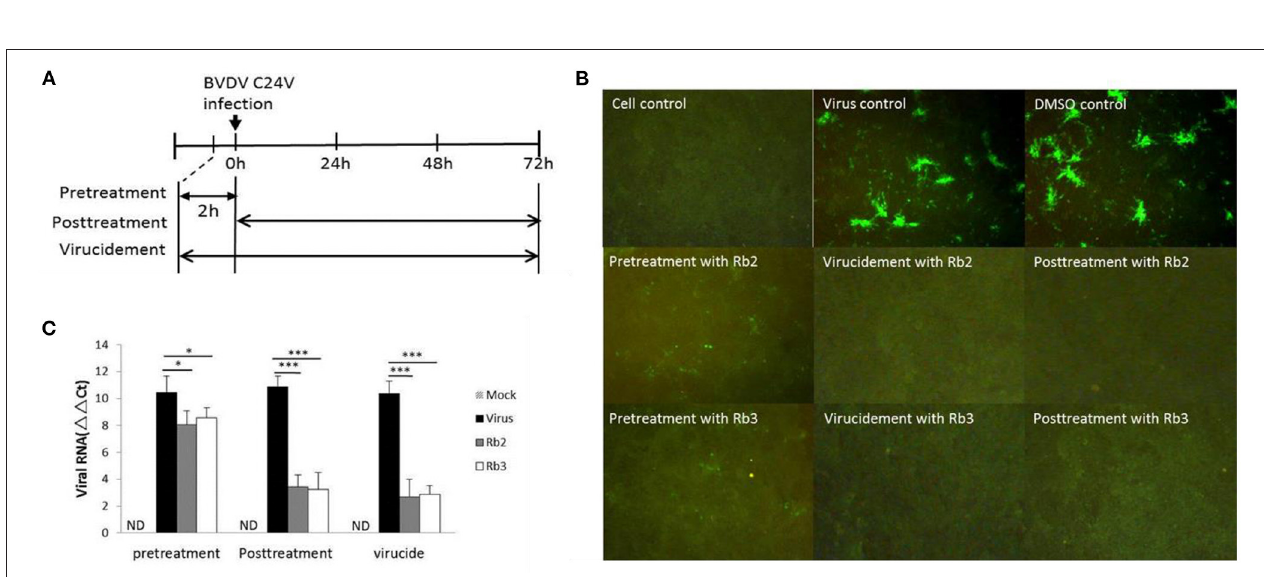
Frontiers in Veterinary Science |